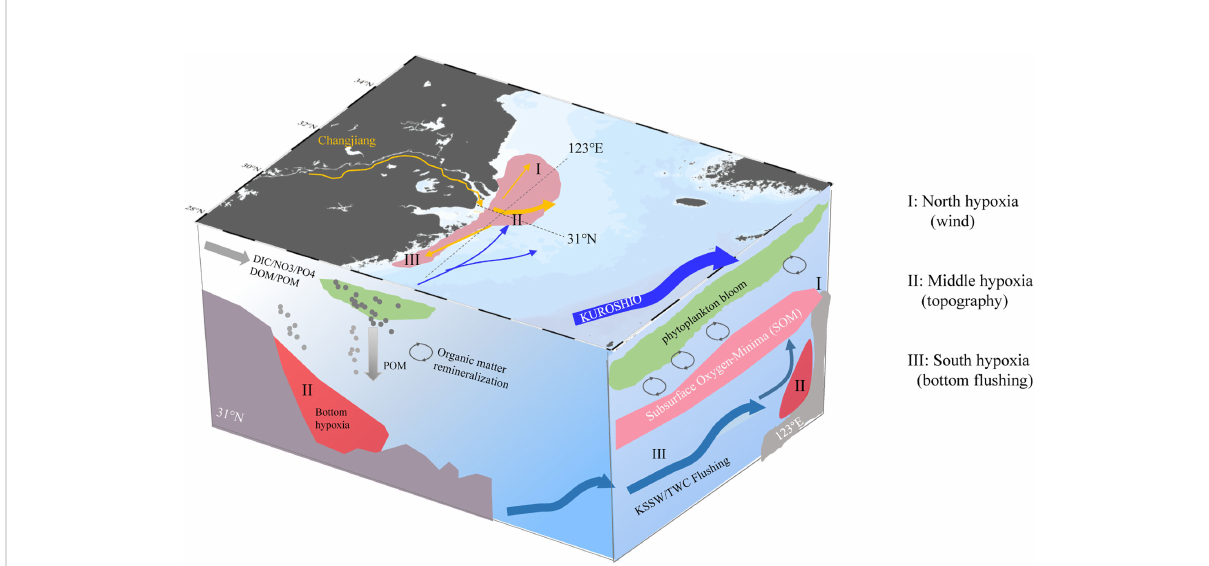
FIGURE 10 Conceptual diagram for three typical hypoxia areas off the Changjiang Estuary and the formation mechanism of subsurface oxygen minima (SOM). Both the cross-shore transect (31°N) and alongshore transect (123°E) are shown in the left and right vertical panels. Round cycles represent the organic matter remineralization. Three are three hypoxia areas (purple shading area of the estuary): the north hypoxia is most likely to encounter severe hypoxia but is easily interrupted by wind events; the middle hypoxia is most commonly observed for its long-lasting character due to topography; and the south hypoxia only existed close to the inner boundary of TWC/KSSW. The SOM usually occurs along the 123°E in the south hypoxia area, regulated by OM respiration and bottom fl ushing